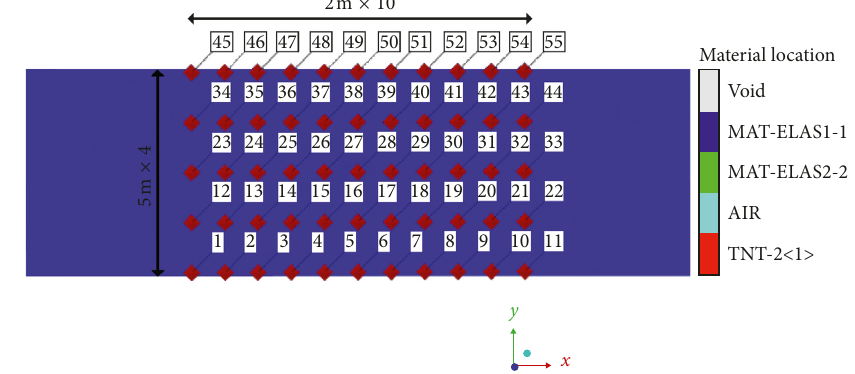
Figure 5: Defined gauges in case of above-deck detonation.